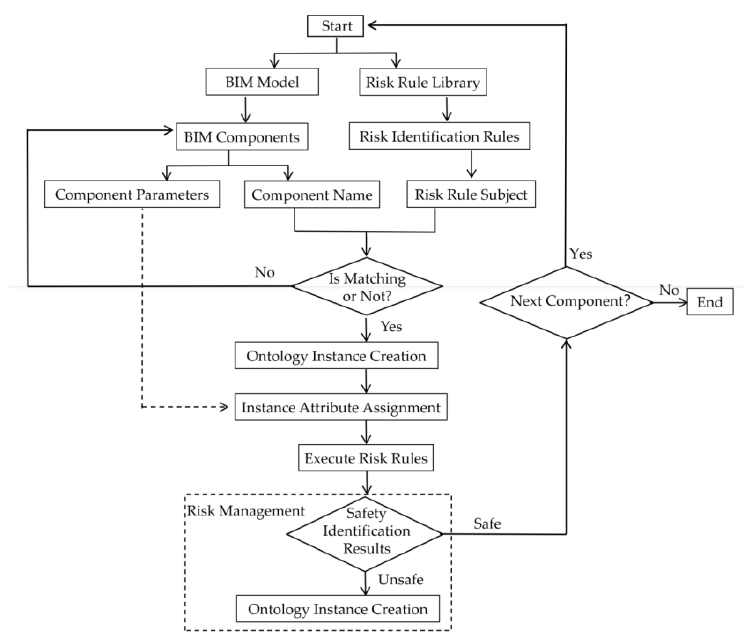
Figure 8. Risk identification mechanism.